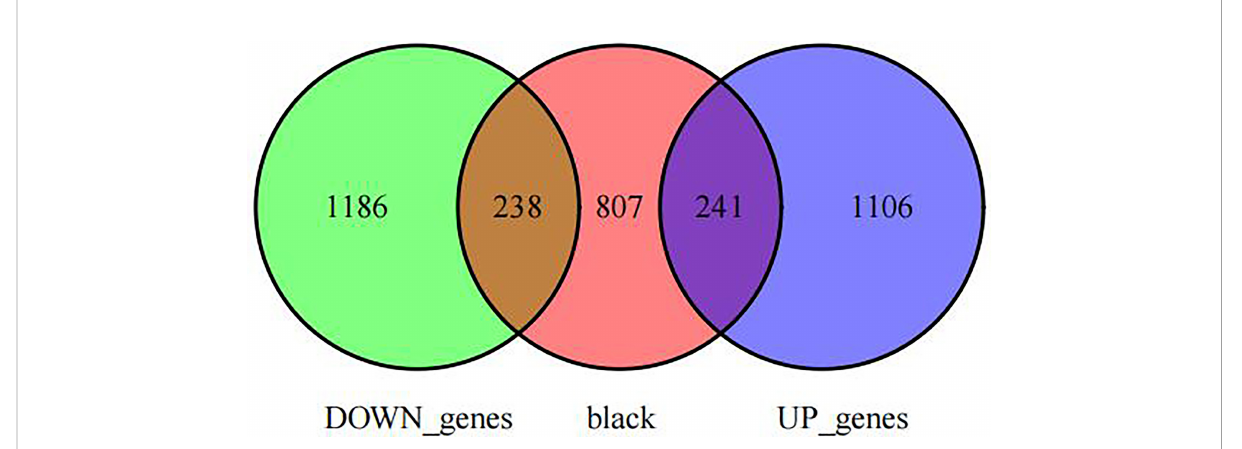
FIGURE 7 Venn diagram of intersections between co-expressed genes and DEGs.